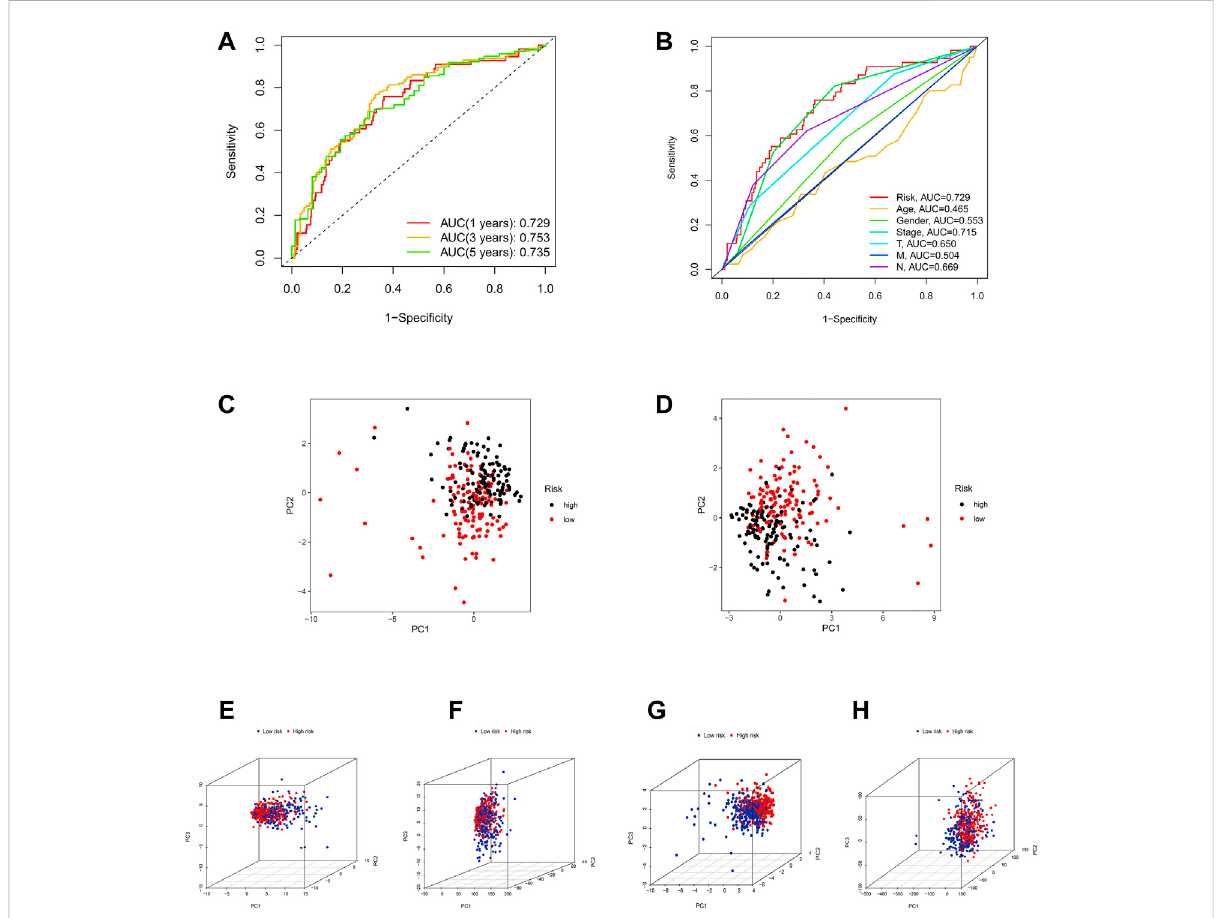
FIGURE 6 AssessmentofthepredictiveriskmodelandPrincipalcomponentanalysis. (A) Theentireset ’ s1-,3-,and5-yearsROCcurves. (B) ROCcurvesof the clinical characteristics and risk score. (C,D) PCA results of testing and training sets. (E – H) The PCA result of entire gene expression pro fi les, ICPDEGs, ICP-related lncRNAs, and risk model according to the 14 hub lncRNAs,